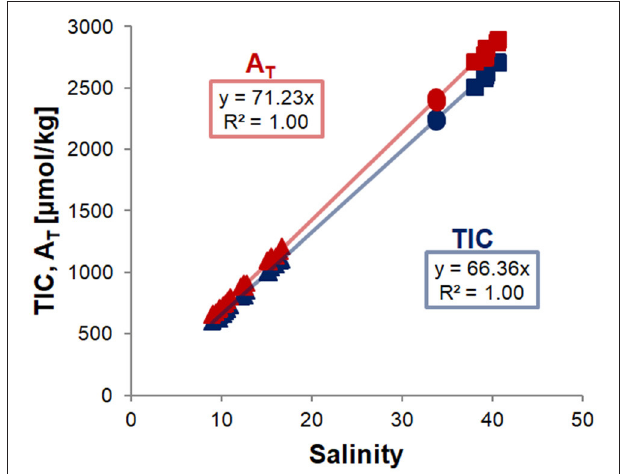
FIGURE 2 | Correlations of TIC (blue) and A T (red) with salinity in water and ice melt samples of all runs. Replicates of water and ice melt samples were averaged for each sampling point and ice core, respectively, and trend lines were fit through all data points, and forced through zero. Error bars are smaller than the symbols. Analytical data are given in Table S2